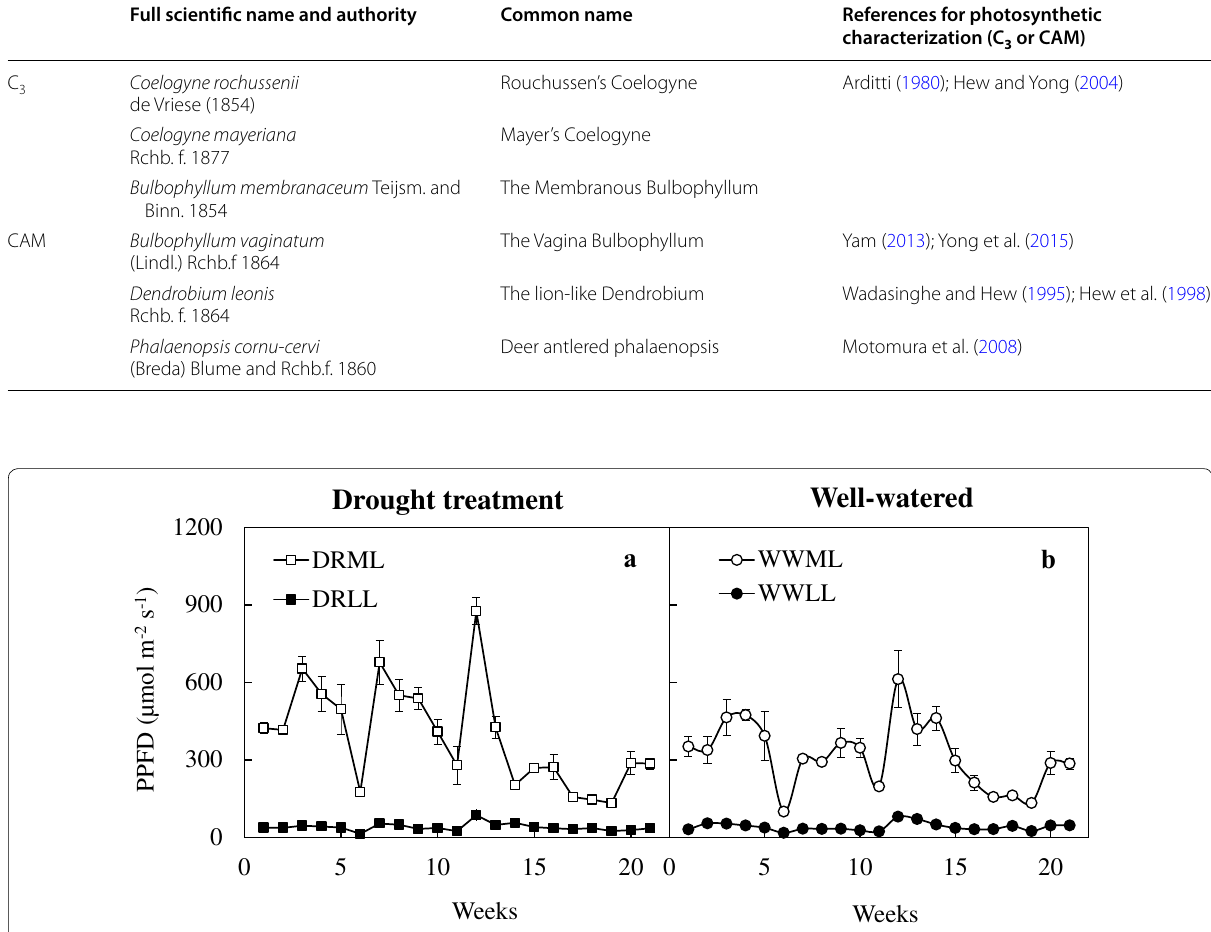
Fig. 1 Weekly changes in PPFD over a 21-week period under drought ( a ) and well-watered ( b ) conditions. Vertical bars represent standard error. n =